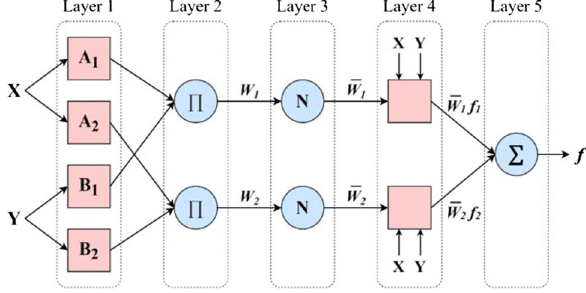
Fig. 4 A big picture of the ANFIS system with two